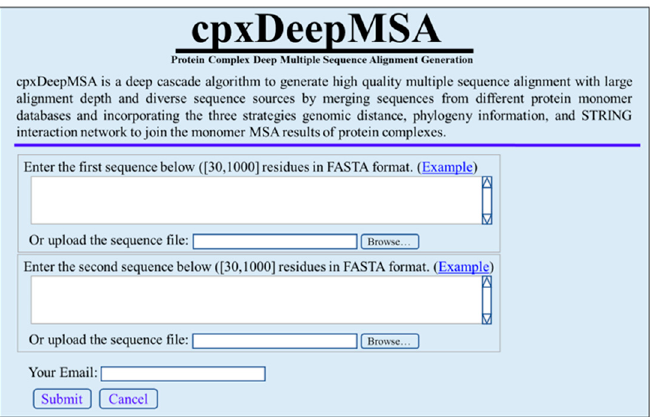
Figure 2. A semi-screenshot showing the top page of the cpxDeepMSA web server at https://zhanggroup.org/cpxDeepMSA/.